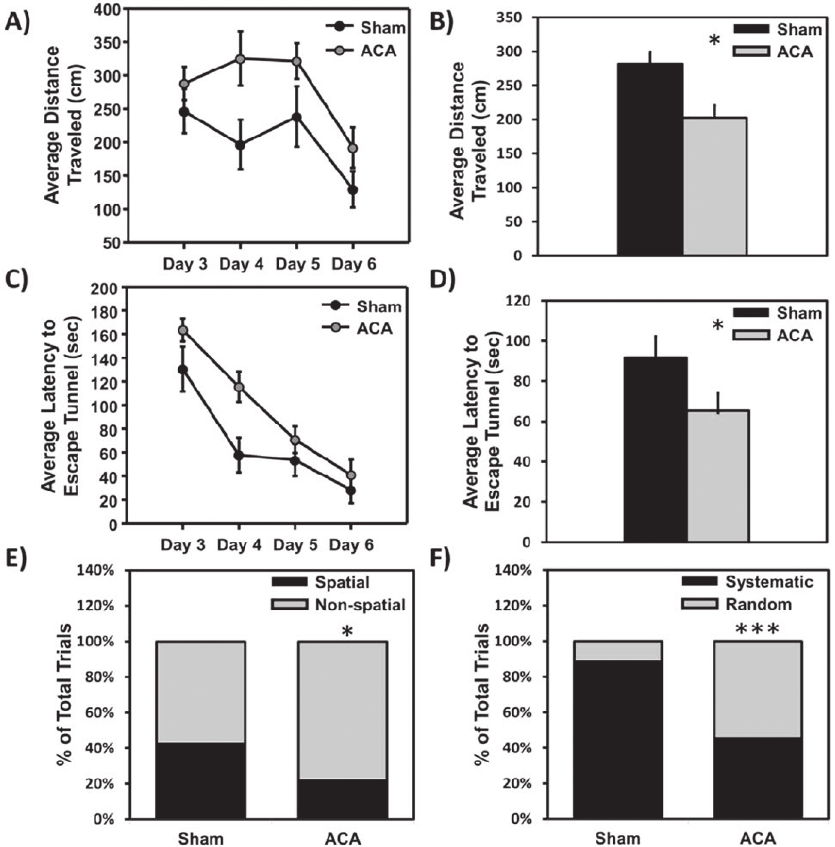
Fig 4. Barnes maze cognitive measurements following Sham or ACA procedure. Average distance traveled A) per day [F (1, 3) = 6.68, * p < 0.05, group effect] or B) across all trials ( ** p < 0.01) on Barnes circular platform maze (testing occurred 3, 4, 5, and 6 days following sham or ACA procedures). The average latency to enter escape tunnel C) per day ( * p < 0.05, group effect) or D) across all trials ( *** p < 0.005, group effect) on Barnes circular platform maze. The percentage of each animal using a search strategy (spatial, serial, or random) was also quantified on the Barnes maze. E) Percentage of trials where an animal used a spatial versus a non-spatial (serial + random) search strategy ( * p < 0.05). F) Percentage of trials where an animal used a systematic (spatial + serial) versus a random search strategy ( *** p < 0.005) (Sham n = 10 and ACA n =